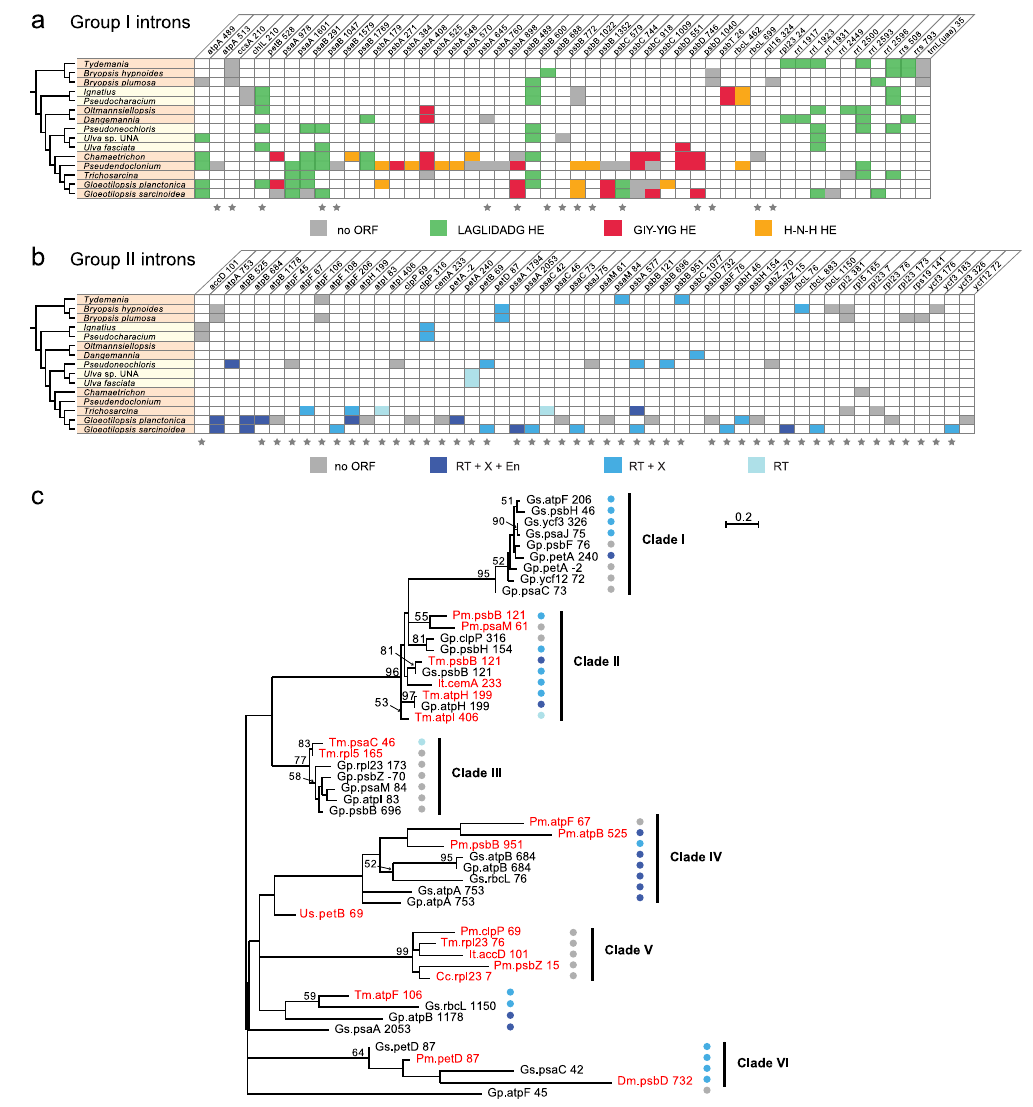
Figure 7. Introns in ulvophycean chloroplast genomes. ( a ) Distribution of group I introns. ( b ) Distribution of group II introns. A grey box denotes an intron lacking an ORF, whereas a colored box represents an intron containing an ORF (see the color code for the type of intron-encoded protein). Stars denote the intron insertion sites that have not been observed in other groups of chlorophytes. Intron insertion sites in protein-coding and tRNA genes are given relative to the corresponding genes in the Mesostigma chloroplast genome 67 ; insertion sites in rrs and rrl are given relative to E . coli 16S and 23S rRNAs, respectively. For each insertion site, the position corresponding to the nucleotide immediately preceding the intron is reported. Abbreviations: EN, H-N-H endonuclease; RT, reverse transcriptase; X, intron maturase. ( c ) Phylogenetic relationships among group II introns of the Ignatiales, Oltmannsiellopsidales, Ulvales and Ulotrichales. The tree shown here was inferred by RAxML analysis of an alignment of 124 nucleotides corresponding to domains IA, IVB, V and VI of the core secondary structure. Bootstrap support values higher than 50% are reported on the nodes. Colored circles denote the types of intron ORF (see the color code on panel b). Note that clades I through IV were identified in a previous phylogenetic study of Gloeotilopsis group II introns 31 . Names of the taxa newly examined in the present investigation are indicated in red. Abbreviations: Cc, Chamaetrichon capsulatum ; Dm, Dangemannia microcystis ; Gp, Gloeotilopsis planctonica ; Gs, Gloeotilopsis sarcinoidea ; It, Ignatius tetrasporus ; Pm, Pseudoneochloris marina ; Tm, Trichosarcina mucosa ; Us, Ulva sp.